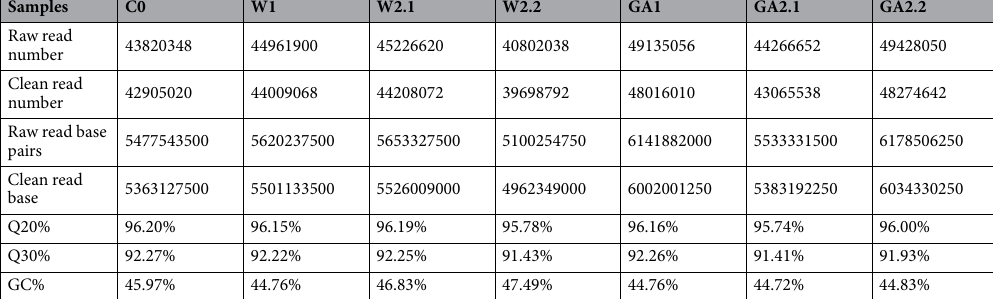
(W2.1 vs W2.2, GA2.1 vs GA2.2) were highly similar (Figure S5), suggesting good reproducibility of the method.